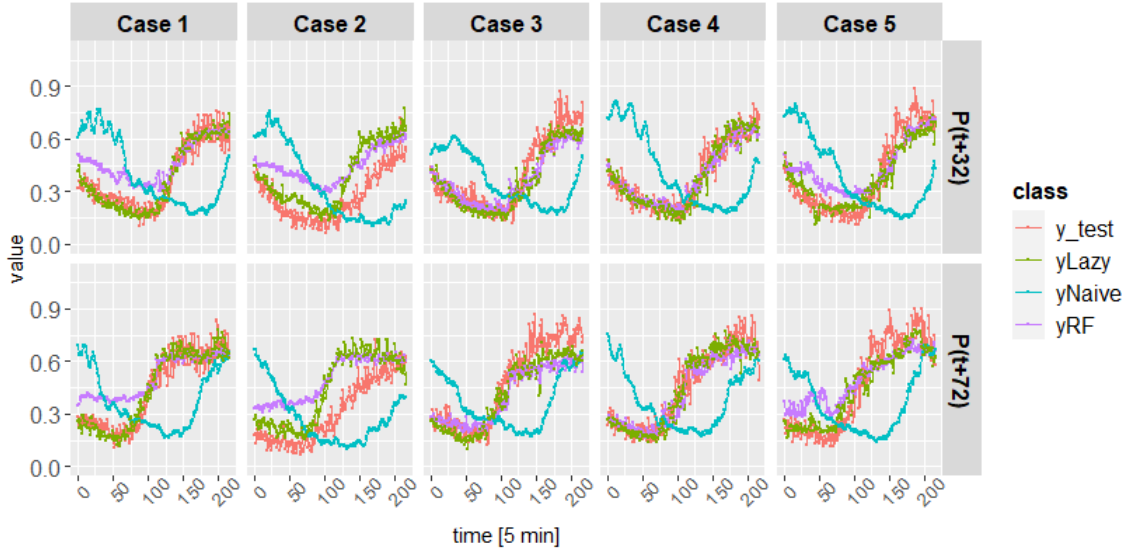
Figure 5. Visualization of actual ( ytest ) and predicted load trajectories for a 6 h forecasting horizon.